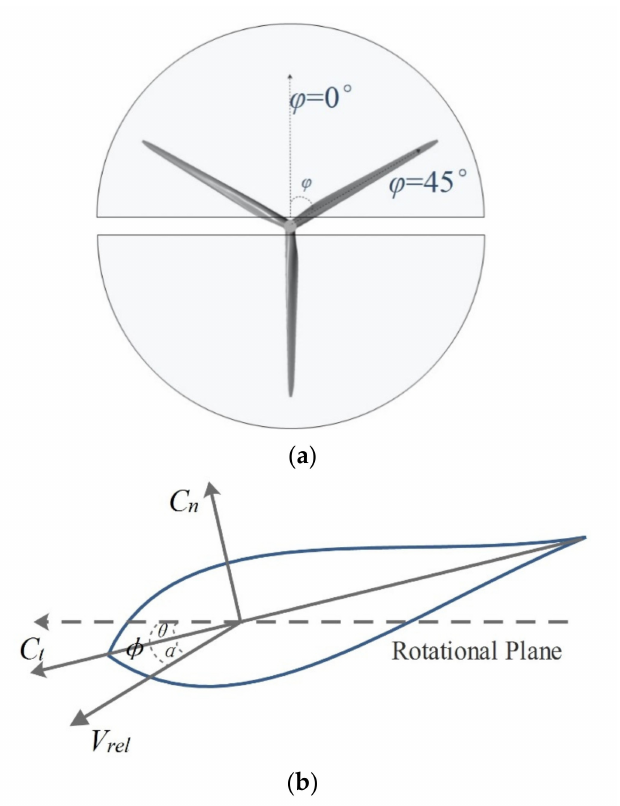
Figure 6. Schematic diagram of azimuth angle and angle of attack ( AOA ). ( a ) Azimuth angle; ( b ) AOA.